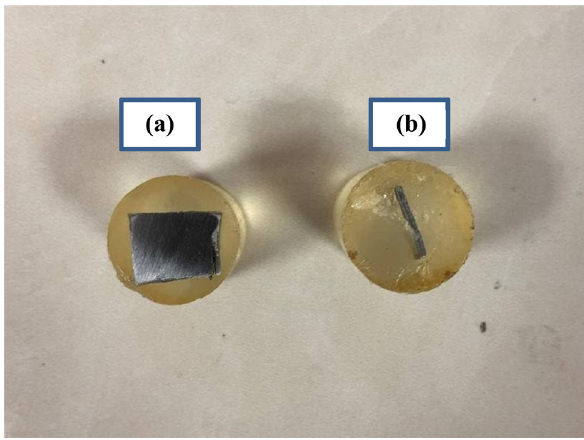
Figure 4: Microstructure specimen. ( a ) Top surface and ( b ) cross